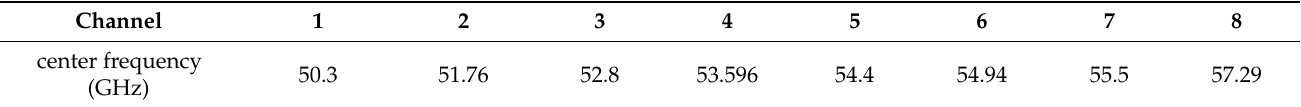
Table 2. Channels for simulated GEO-MW brightness